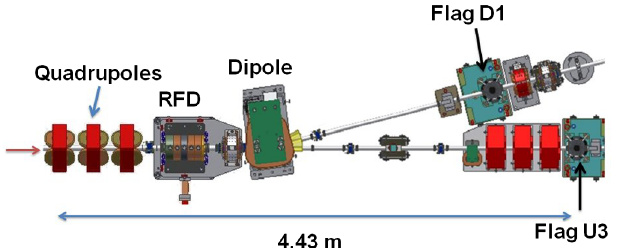
FIG. 1. Sketch of the SPARC_LAB diagnostic section beam line. The beam is coming from the left side. The drawing is not to scale. From left to right are visible the quadrupole triplet, the RFD (rf deflector), the dipole and the two view screens used in the measurement (named as flag D1 and